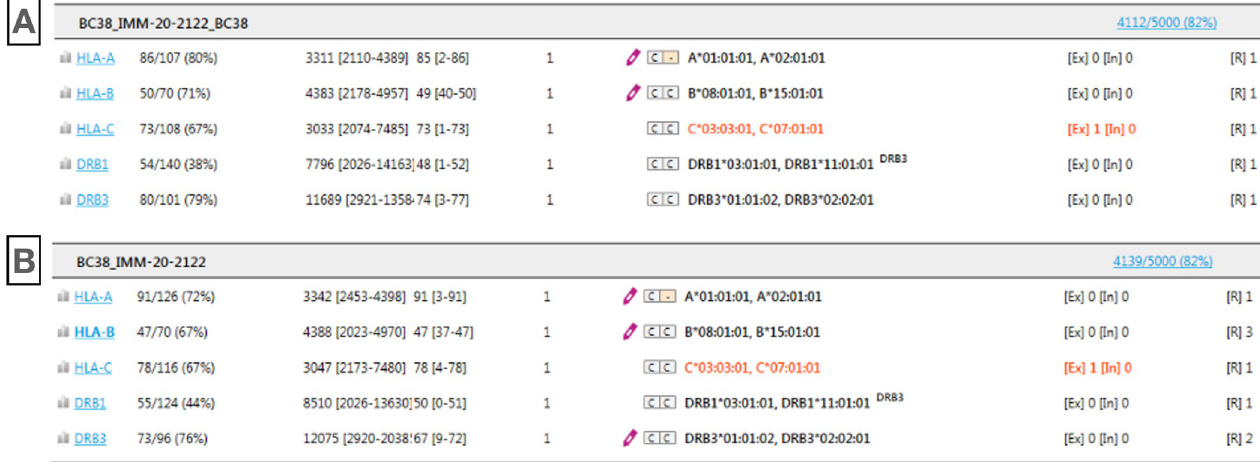
Fig 5. Analysis snapshot from NGSengine of sample #38 obtained from the automatic pipeline in Azure cloud platform (A panel) and the manual analysis workflow onsite (B panel).